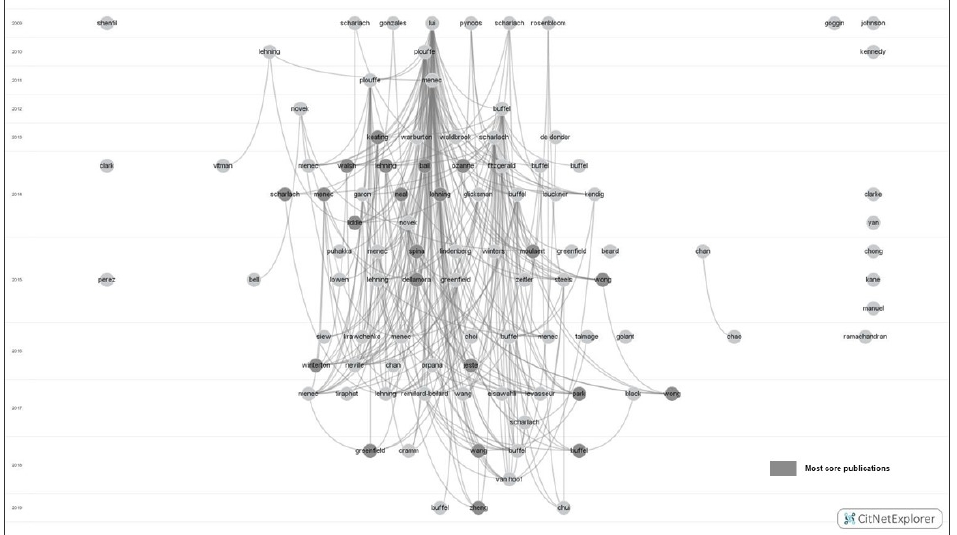
Figure 3. More-core publications among age-friendly community studies (K-core algorithm: K = 5 and 6). Table 2. Number of publications in different core publication categories.